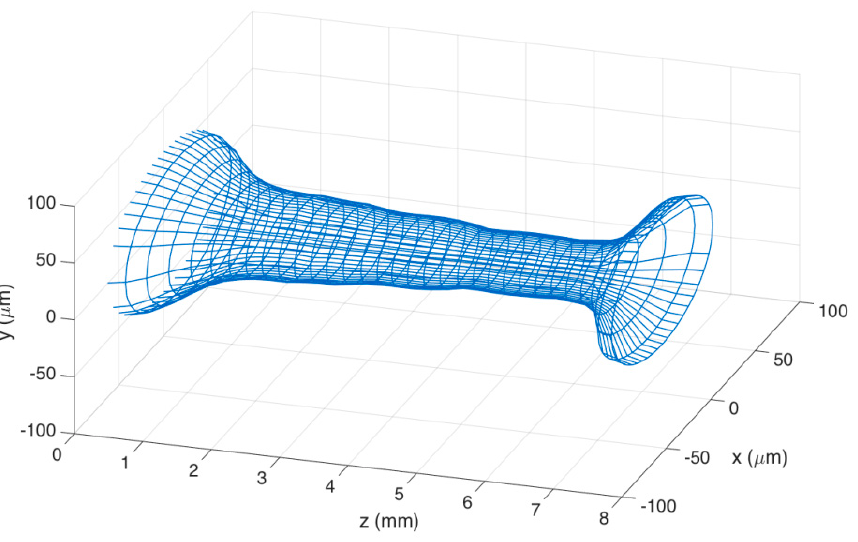
Figure 4. 3D mesh of the fabricate